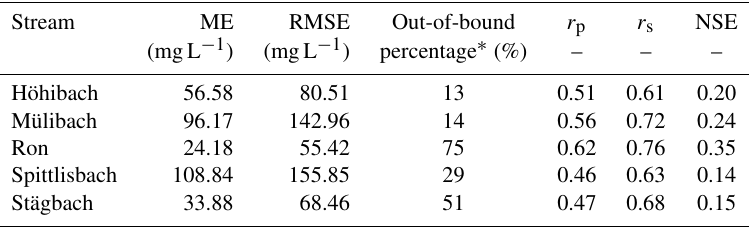
Table 4. Evaluation metrics of the sediment rating curve, considering the measured sediment concentrations and median of the simulations. Stream ME RMSE Out-of-bound r p r s NSE percentage ∗